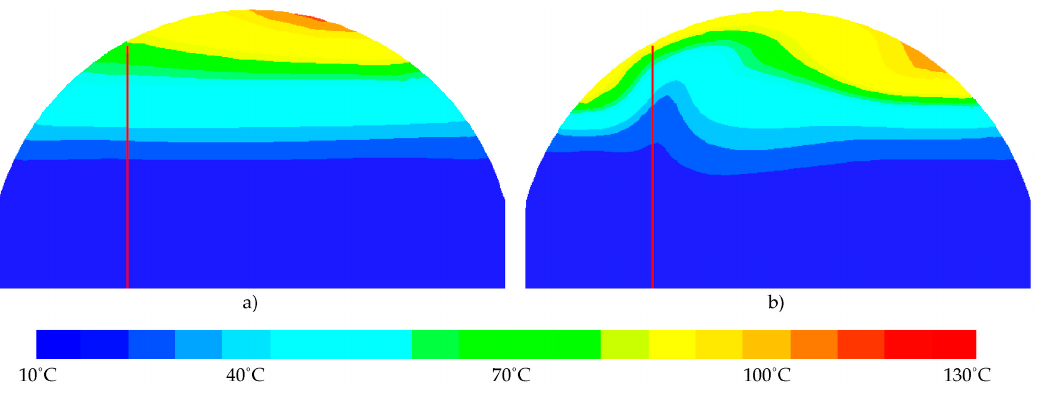
Figure 13. Temperature distributions in 160 s of fire development at two perpendicular cross-sections at a distance of 5 m from fire source: ( a ) on windward, ( b ) on leeward. The plane of fire source is marked by the red line